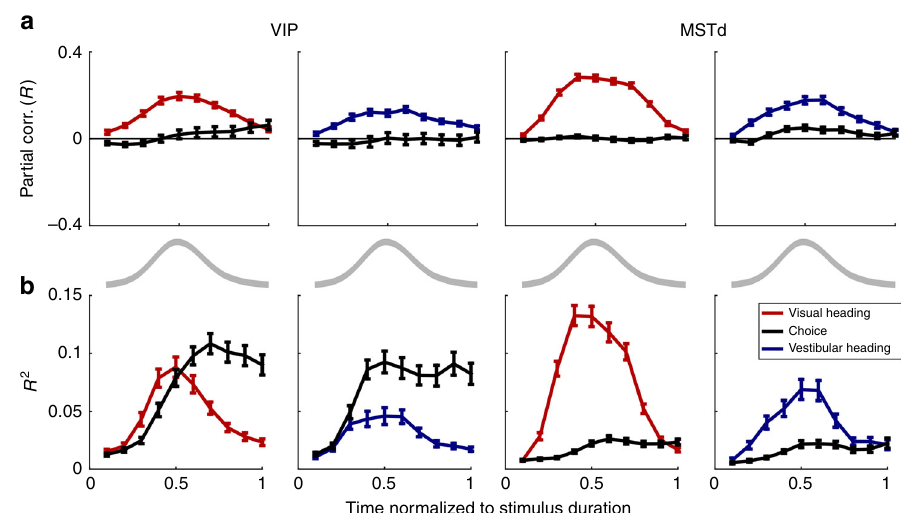
Fig. 4 Partial correlations as a function of time. Partial correlation data are presented for areas VIP ( left two columns) and MSTd ( right two columns). Heading partial correlation data are presented in red for the visual condition and in blue for the vestibular condition. The respective choice partial correlations are presented in black . a The average partial correlations were aligned to each cell ’ s heading preference by inverting the signs of both the heading and choice partial correlations when the overall heading partial correlation was negative (done separately for visual and vestibular conditions). On average, the choice partial correlations across cells cancel out, indicating no consistent alignment to heading preferences. b Squared partial correlations ( R 2 ) are presented, such that positive and negative contributions from different neurons did not cancel. The gray lines below a depict the stimulus velocity pro fi le. Cell selection and N values are the same as in Figs. 2 and 3. The old and new data were pooled in this plot, and the horizontal axis shows time normalized to stimulus duration, which was different for the new and old data sets. See also Supplementary Fig. 5 for a more direct comparison of the choice partial correlations across areas and stimulus modalities ( R 2